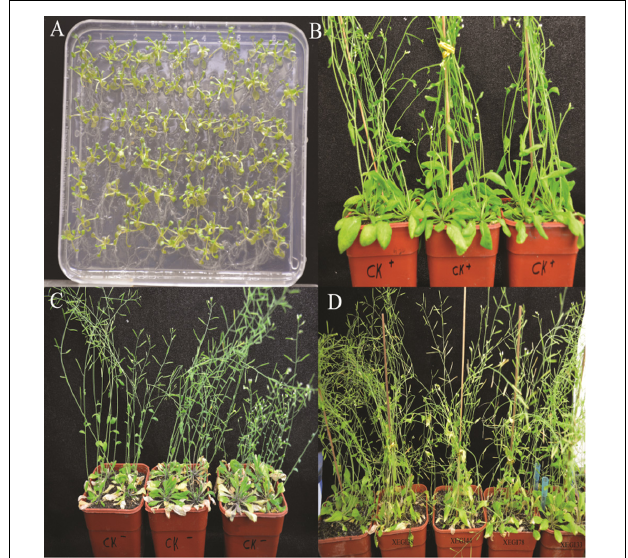
FIGURE 2 | Defense response to V. dahliae in Arabidopsis thaliana plants (A) A. thaliana seedling; (B) A. thaliana without inoculation of V. dahliae ; (C) Response of A. thaliana to V. dahliae ; (D) Response of A. thaliana to V. dahliae inoculated with different endophytic strains after 5 weeks.